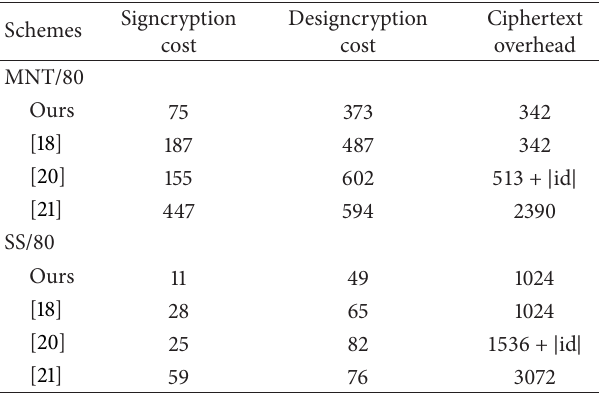
Table 4: Performance comparison of the CBSC